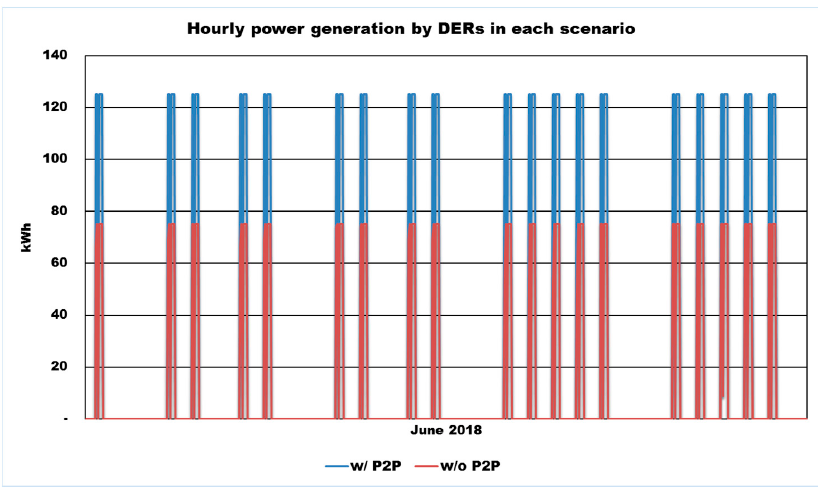
Figure 10. Comparison of hourly power generation by DERs in each scenario.